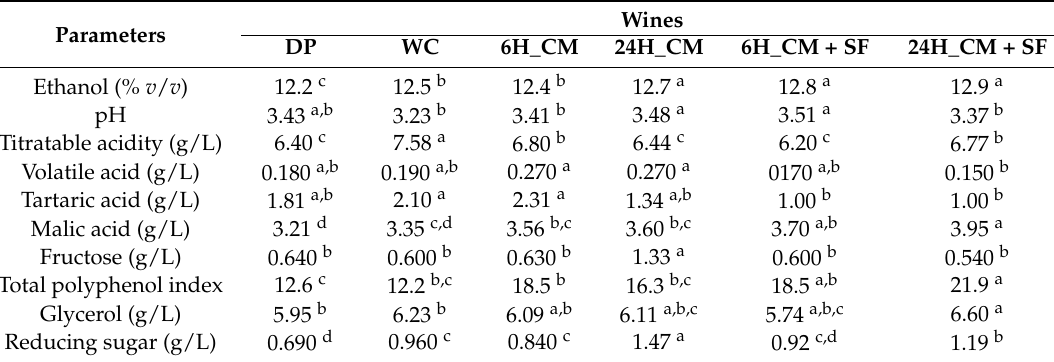
Table 3. Chemical parameters of the final “Solaris” white